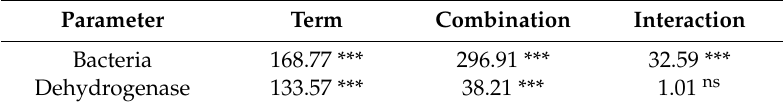
Table 4. F test statistics and significance levels of two-way analysis of variance for the cell count and activity of microorganisms; the combination and terms of tests were fixed factors (*** p = 0001, ns—no significant di ff